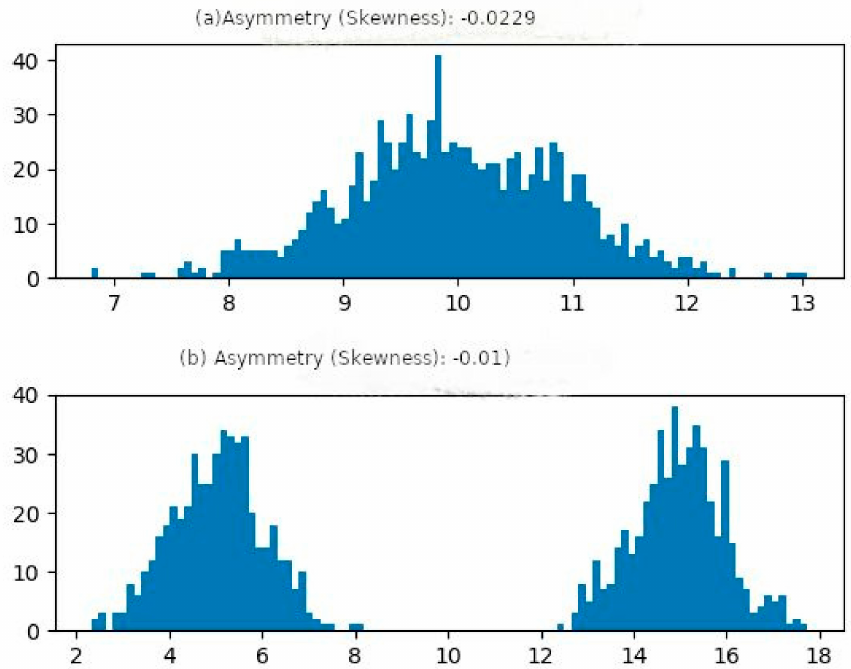
Figure1. SetsclassifiedasplatikurticbyHephaestus—( a )monomodalsymmetry( b